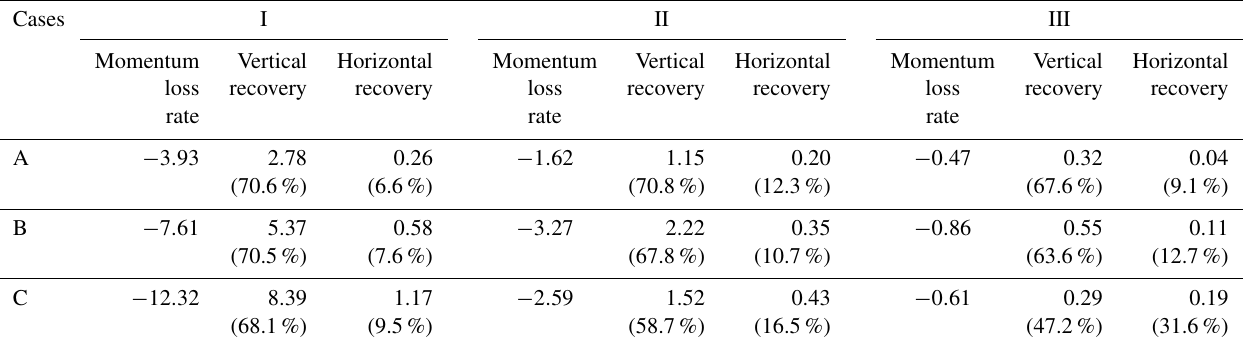
the wind farm and the simulation period. The numbers in the parentheses give the percentage recovery with respect to the corresponding momentum loss